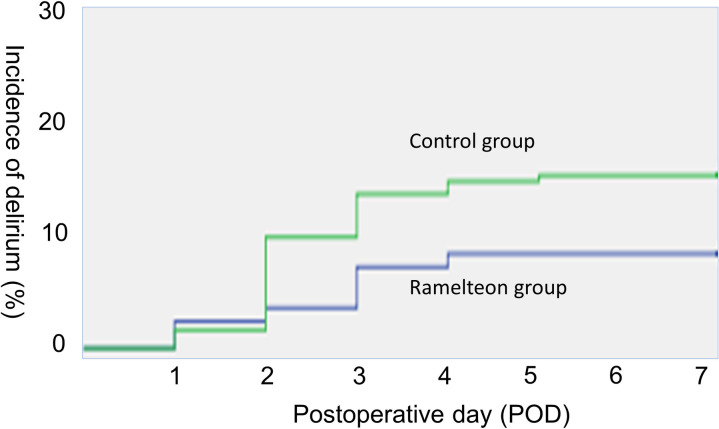
The cumulative incidence of postoperative delirium in each group is shown.The incidence of postoperative delirium was significantly lower in the ramelteon group than in the control group (P = 0.035).